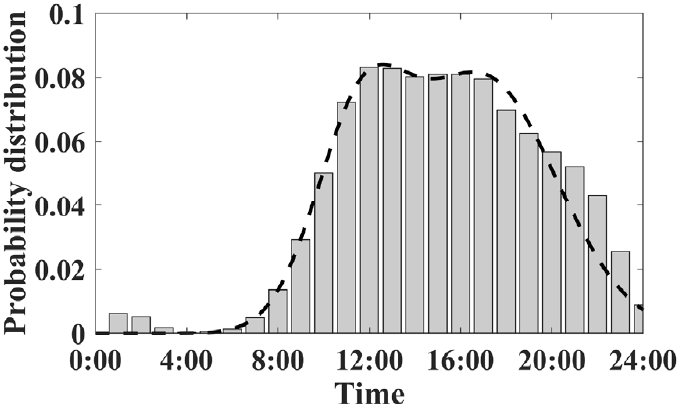
Figure 3. Distribution of end time of social shopping trip at weekends.